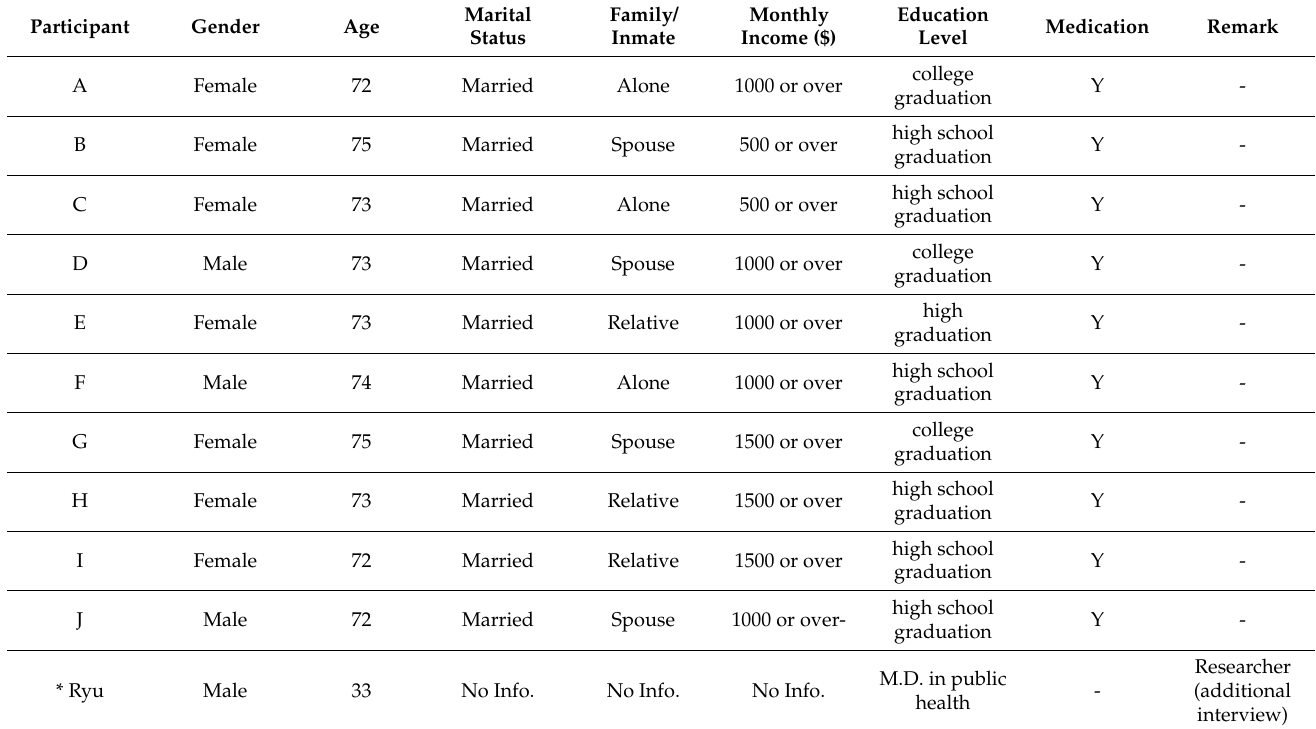
Table 2. General Characteristics of